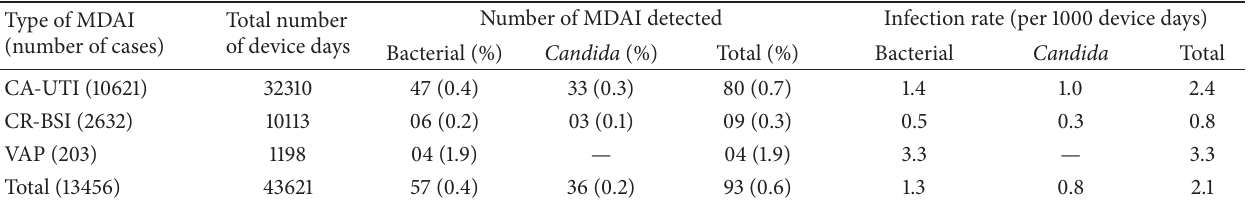
Table 1: Rate of medical device-associated infections.